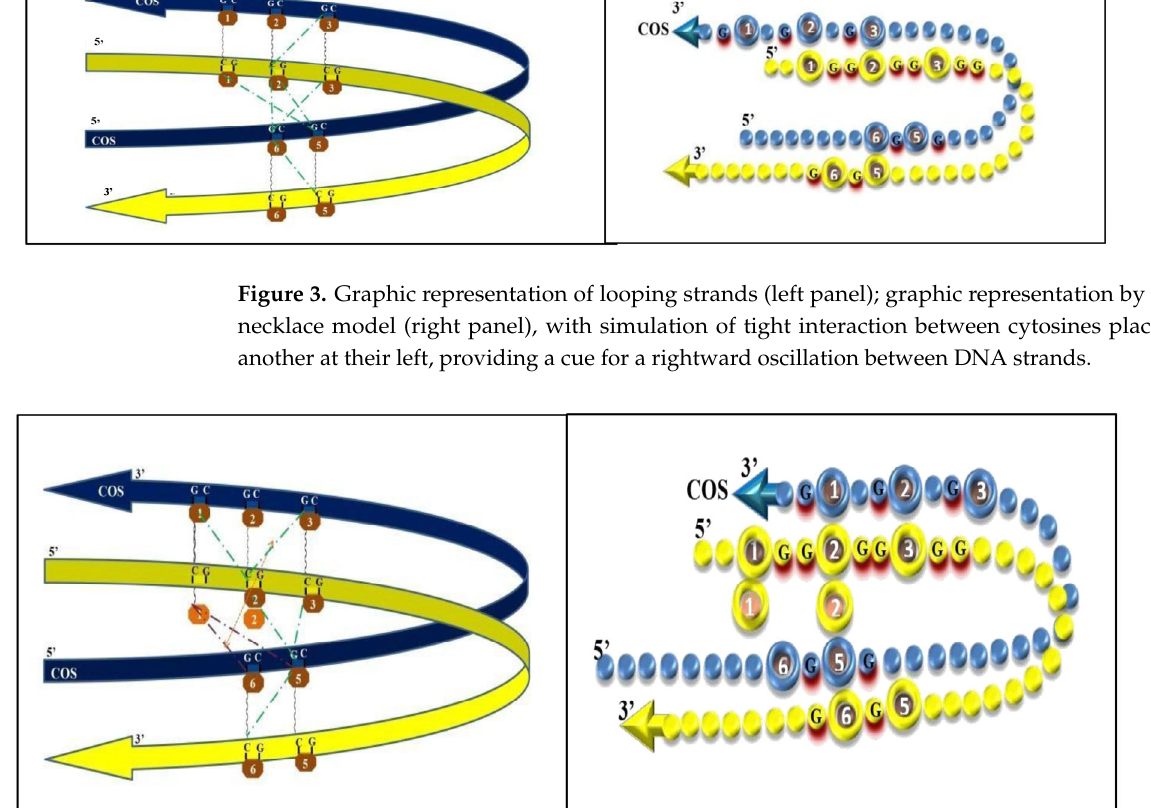
Figure 4. Graphic representation of looping strands (left panel); graphic representation by a pearl necklace model (right panel), with simulation of tight interaction between cytosines placed one another at their right, providing a cue for a leftward oscillation between DNA strands.